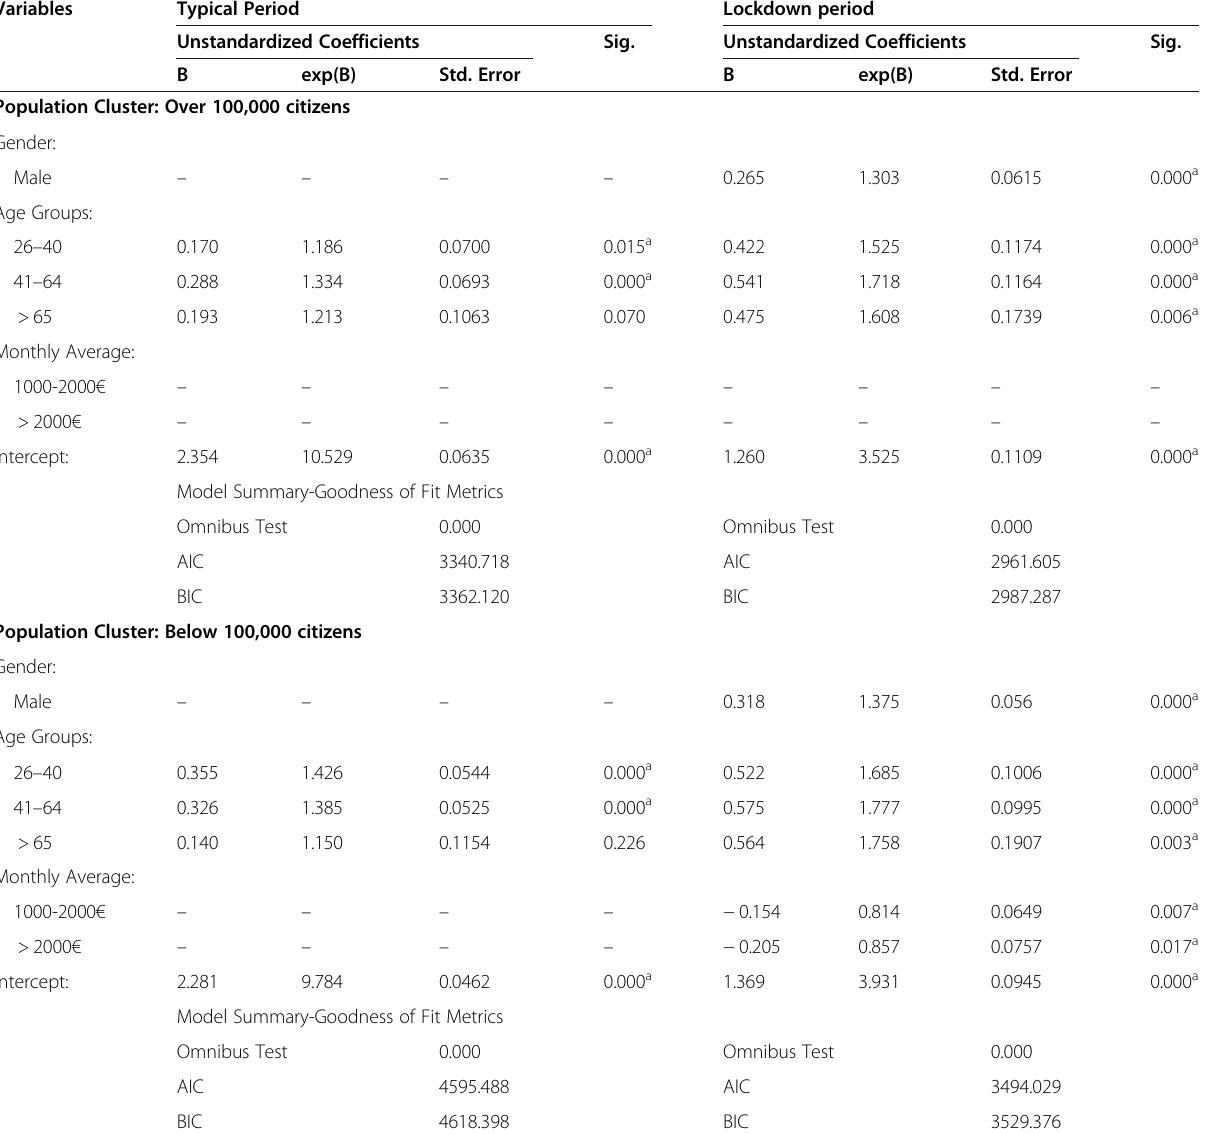
Table 4 Results of total number of weekly trips per person in the typical & lockdown periods for 2 population clusters Variables Typical